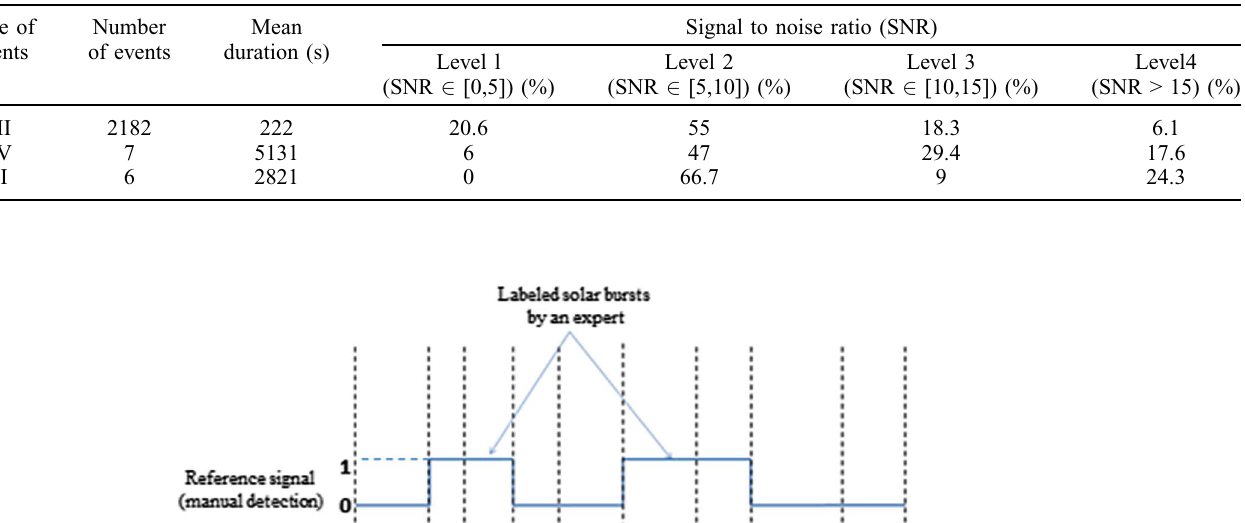
Table 1. Table of distribution of the data-set of solar events detected manually from June 2012 and June